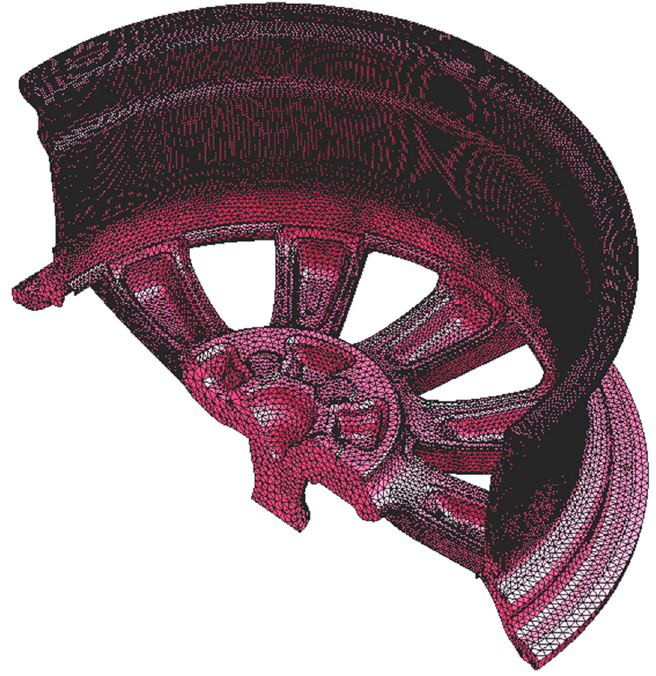
Figure 20. Wheel geometry and mesh (469,100 2D elements and 2,896,039 3D elements) used for additional model validation (Die-B).